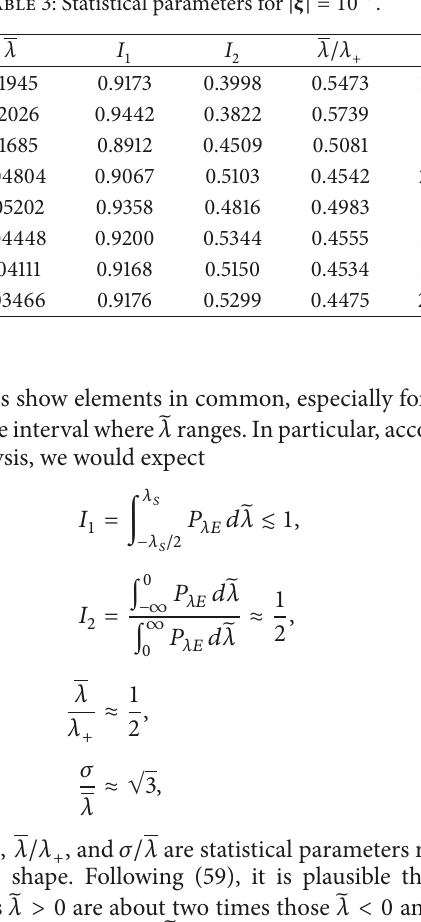
Table 3: Statistical parameters for | 𝜉 | = 10 −3